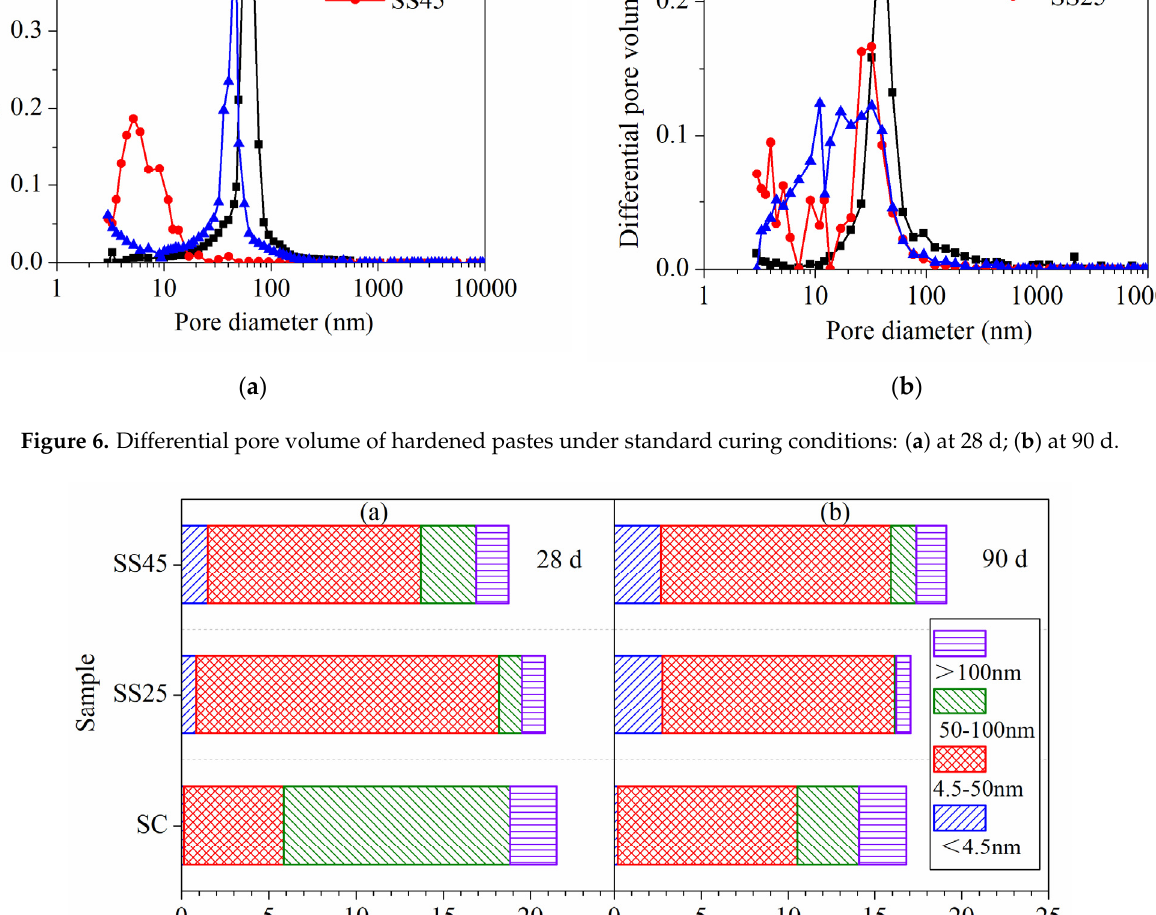
( b ) Figure 8. Differential pore volume of hardened pastes under temperature-matching curing conditions: ( a ) at 28 d; ( b ) at 90 d.